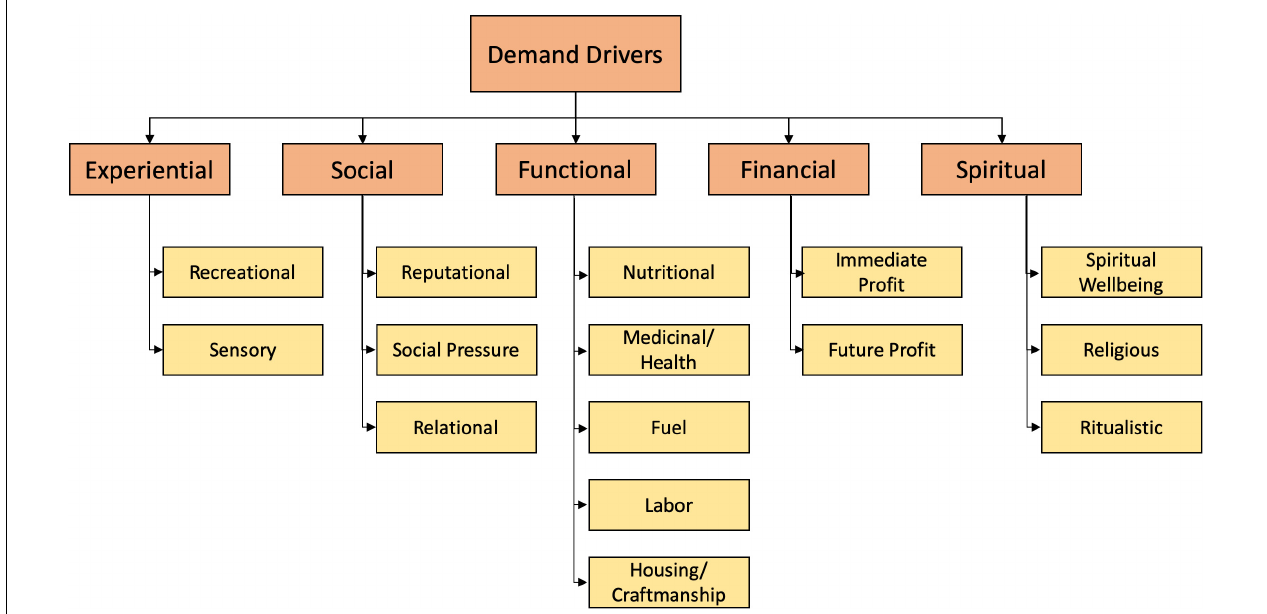
FIGURE 2 | Framework for the motivations behind the use of wildlife products adapted from Thomas-Walters et al. (2020a).